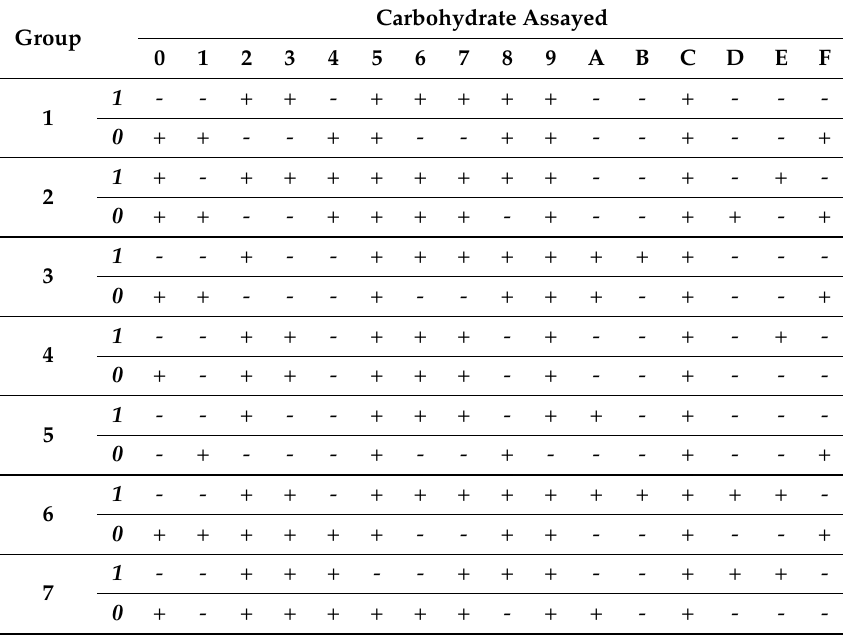
Table 3. API 32C assays for different groups of